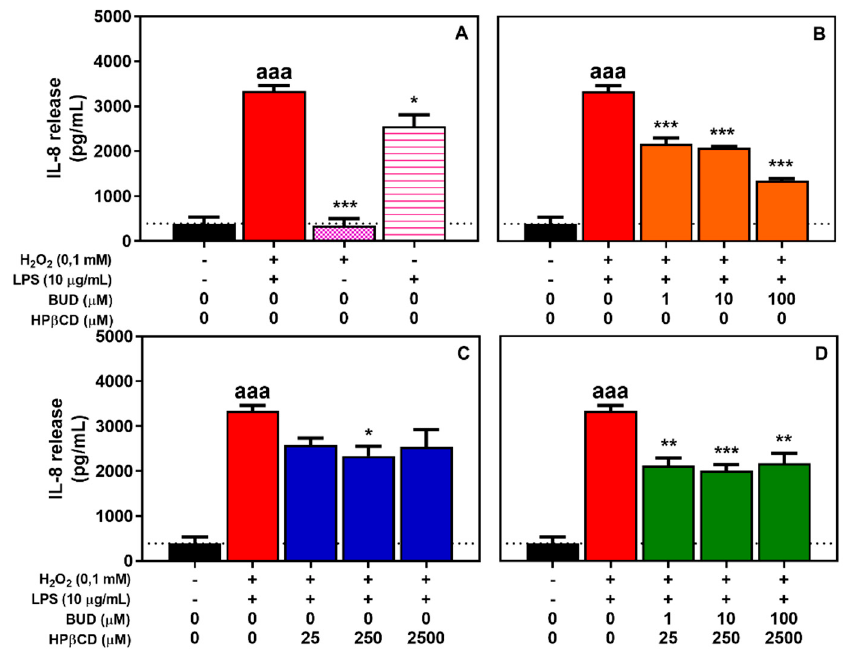
Figure 9. IL-8 release by A-THP-1 cells after treatment with H 2 O 2 , LPS or H 2 O 2 + LPS for 2 h ( A ) and e ff ect of BUD ( B ), HP β CD ( C ), and BUD:HP β CD complex ( D ) on H 2 O 2 + LPS-induced IL-8 release. IL-8 release was measured in the extracellular medium by sandwich ELISA. Each bar represents the mean ± SEM of 3 independent means of triplicated measures. A one-way ANOVA with Dunett post-test was used to compare the mean of each test group with the mean of untreated group or H 2 O 2 + LPS-treated group. The di ff erence was considered significant for a p -value < 0.05; (aaa), indicate p < 0.001 versus untreated group; (*), (**), and (***) correspond to p < 0.05, 0.01 and 0.001 versus H 2 O 2 + LPS-treated group,